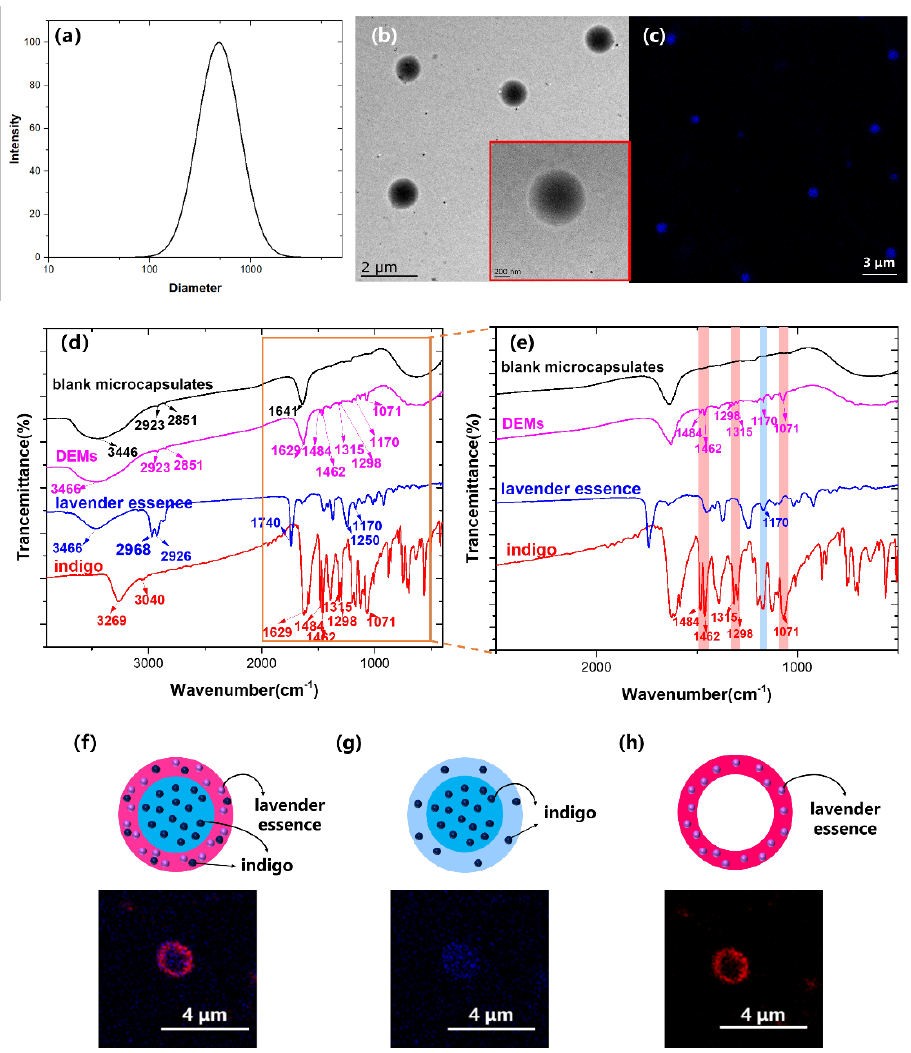
Figure 1. ( a ) Dynamic Light Scattering (DLS) results, ( b ) Transmission Electron Microscopy (TEM) images and ( c ) Confocal Laser Scanning Microscope (CLSM) image of DEMs. ( d ) Fourier Transform Infrared Spectroscopy (FT-IR) spectra and ( e ) enlarged partial IR spectra of blank microcapsules, DEMs, lavender essence and indigo. ( f − h ) Schematic representations and CLSM images of the microcapsules containing both molecules, indigo dye, and the Nile Red-stained lavender essence.